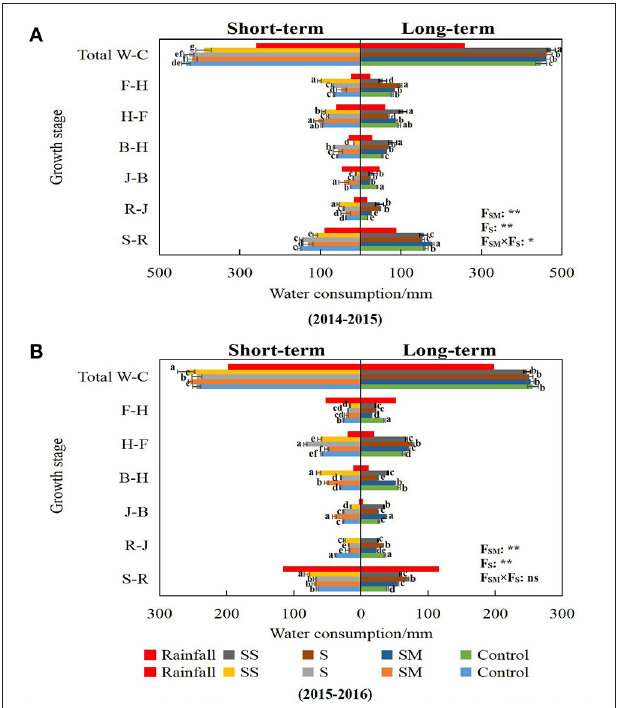
FIGURE 5 | Water consumption in different growth stages of wheat under the Control, SM, S and SS treatments in different years. Error bars represent standard deviation ( n = 3). Columns labeled with different letters represent significant differences at P < 0.05 among treatments of two experiments at same growth stage. (A) 2014962015 and (B) 2015962016. Control, conventional tillage; SM, straw mulching; S, subsoiling; SS, subsoiling + straw Filling-harvest; W-C, total water consumption. F SM , F S and F SM × F S mean F-values of straw mulching, subsoiling and their interactions in variance